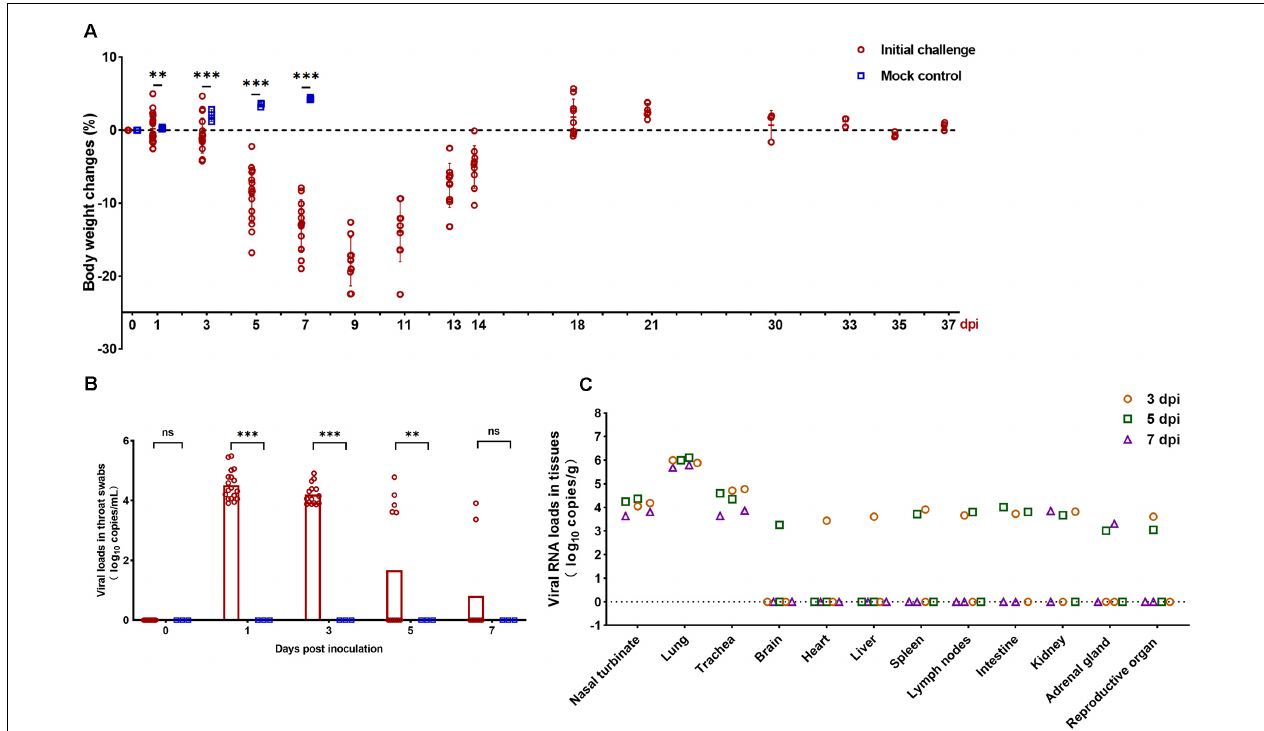
FIGURE 1 | Clinical characteristics and viral load in the collected organs. (A) Body weight changes in Syrian hamsters after viral infection at 0, 1, 3, 5, 7, 9, 11, 13, 14, 18, 21, 30, 33, 35, and 37 days post inoculation (dpi). The mock-infected hamsters were examined at 0, 1, 3, 5, and 7 dpi. (B) Viral RNA (log10 RNA copies/mL) by qRT-PCR assay detected in the throat swabs at 0, 1, 3, 5, and 7 dpi. (C) Viral RNA (log10 RNA copies/g) by qRT-PCR assay detected in the respiratory tract tissues and extrapulmonary organ tissues of SARS-CoV-2-challenged hamsters at 3, 5, and 7 dpi. Statistical significance in (A,B) was calculated between infected and mock-infected animals within each group. The data shown are the mean ± SEM. Statistical significance between groups was calculated by Student’s t-test ( ns P > 0.05, ∗∗ P < 0.01, ∗∗∗ P < 0.001).